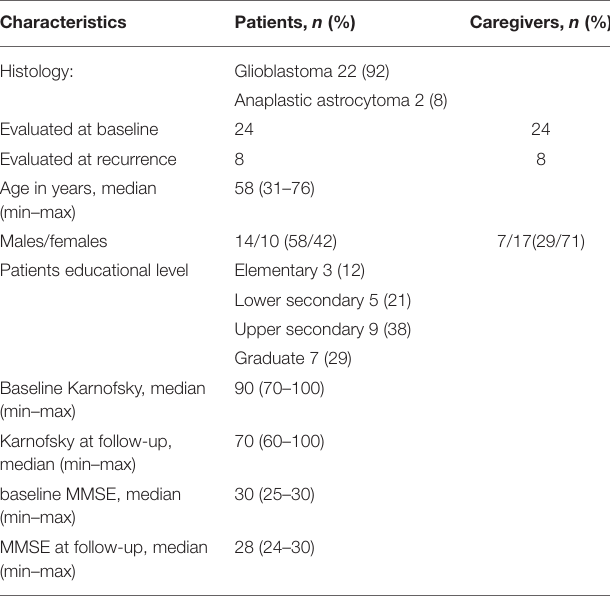
TABLE 1 | Patients’ and caregivers’